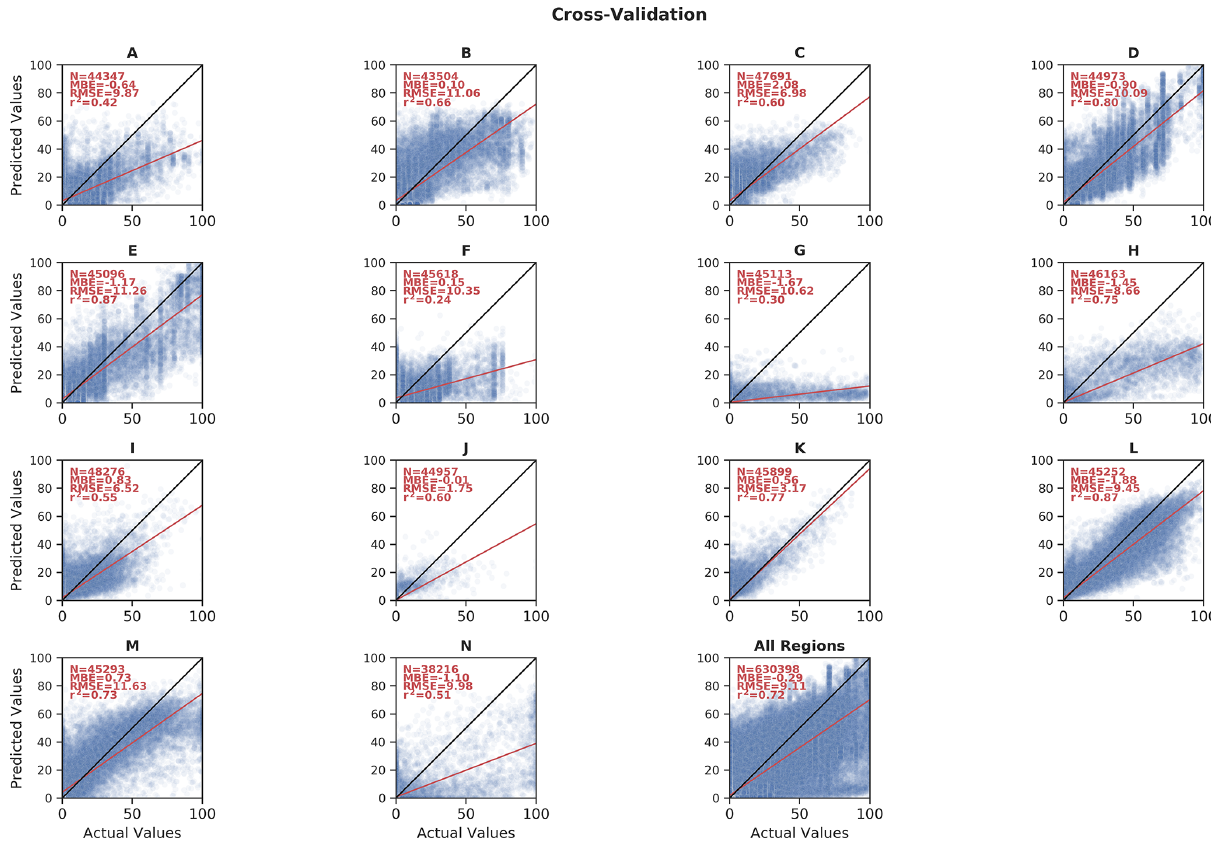
Figure A4. Scatterplots of the CV trials for Peat-ML (Peat-ML CV)-predicted peatland extent and peatland extent from the peatland training datasets over the 14 BLOO CV